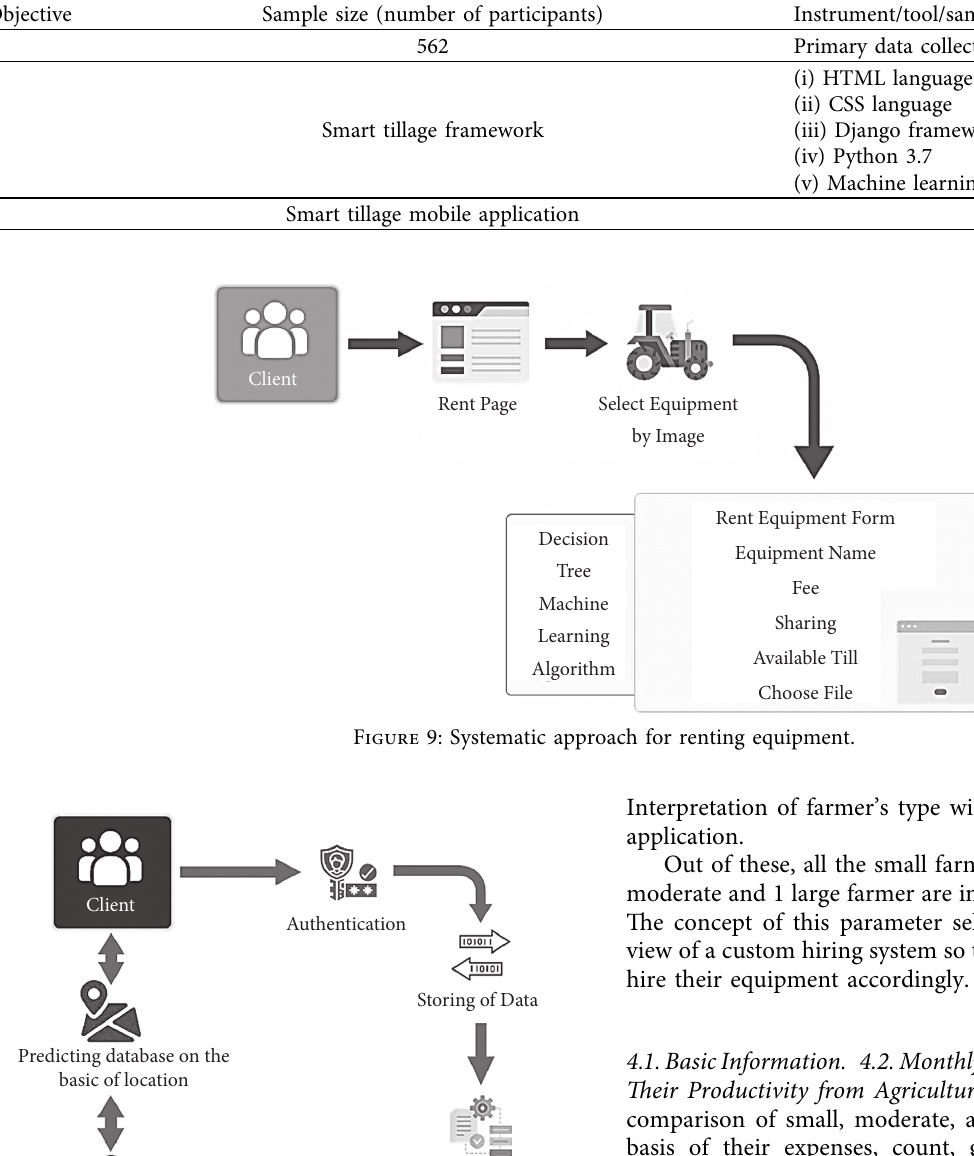
Table 3: Methodology/tools/instruments to be used.